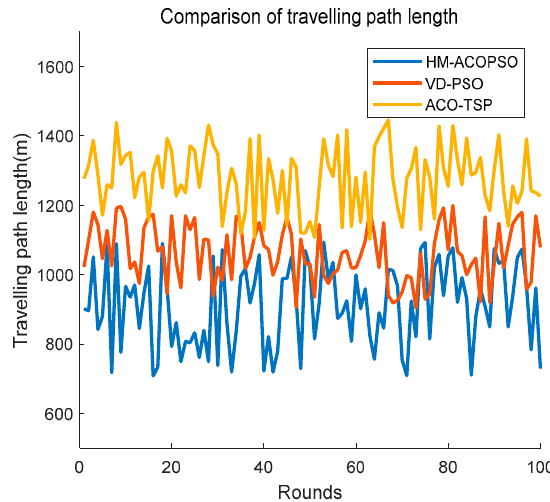
Figure 10. The traveling path length of the mobile agent.